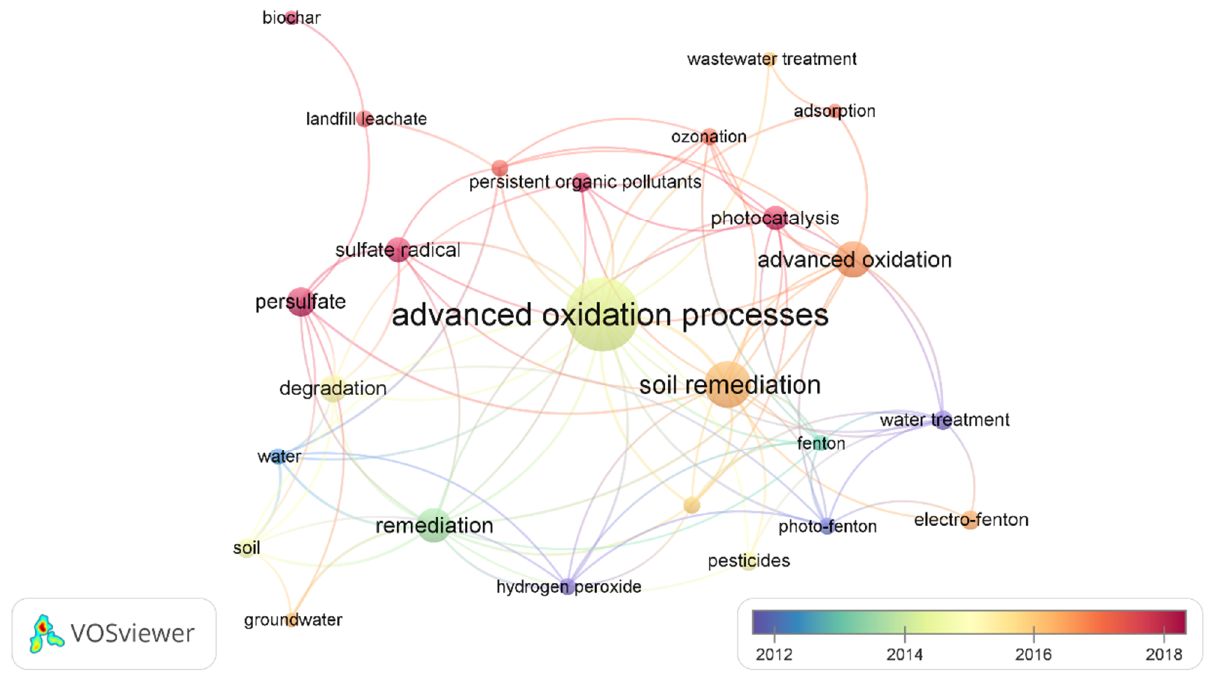
Figure 1. Keyword and overlay visualization co-occurrence analysis of advance oxidation processes to soil research using the VOS Viewer ® . The blue nodes represent the keywords appearing earlier, whereas the red nodes reflect their recent occurrence.